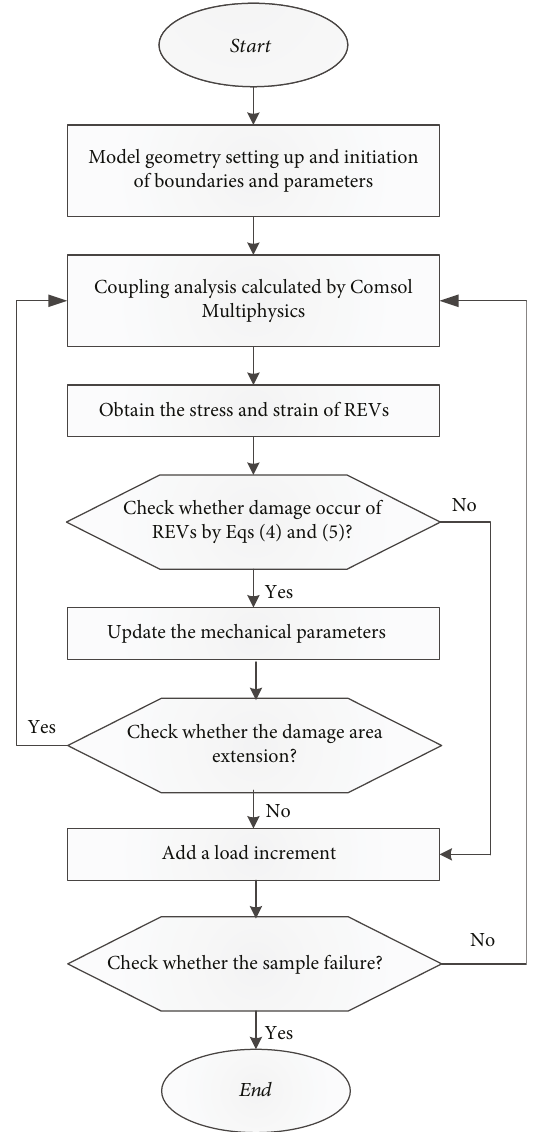
Figure 3: Calculation procedures of the numerical model.